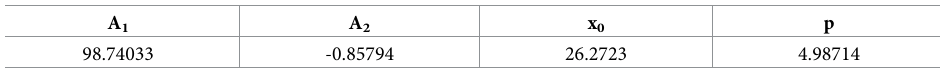
Table 27. Fitting equation parameters of accessibility of 30–23.